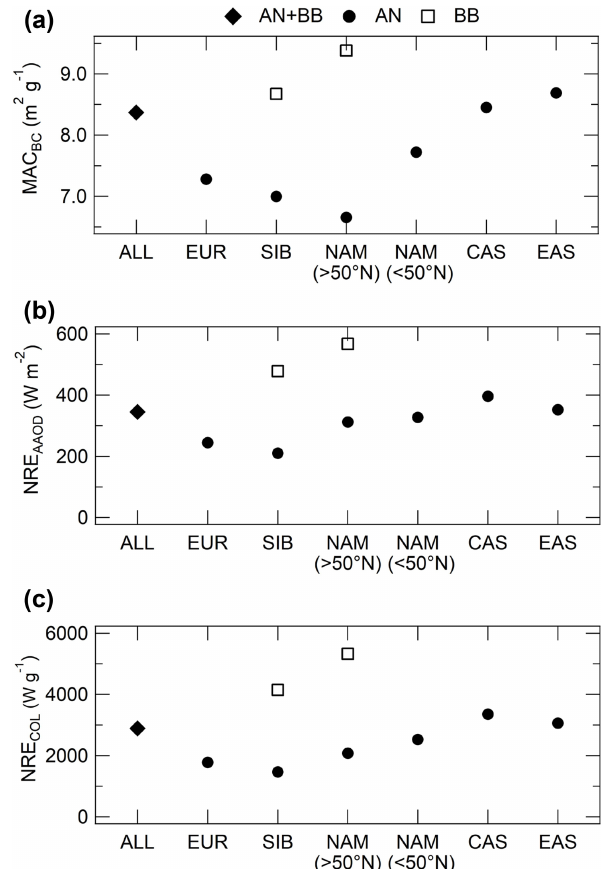
Figure 11. Optical properties and radiative effect efficiencies in the Arctic for total BC (ALL; from all sources) and BC from the eight major sources (six anthropogenic (AN) sources and two biomass burning (BB) sources): (a) mass absorption cross section of BC (MAC BC ), (b) BC radiative effect normalized by absorption aerosol optical depth (AAOD) of BC (NRE AAOD ; RE BC_TOA / AAOD BC ), and (c) BC radiative effect normalized by M BC_COL (NRE COL ; RE BC_TOA /M BC_COL